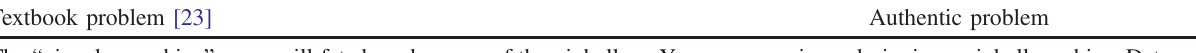
TABLE I. An example of the contrast between textbook [23] and real-world problems. Textbook problem [23] Authentic problem The “ pincube machine ” was an ill-fated predecessor of the pinball machine. A 100 g cube is launched by pulling a spring back 12 cm and releasing it. The spring ’ s constant is 65 N = m. What is the cube ’ s launch speed as it leaves the spring? Assume that the surface is frictionless.